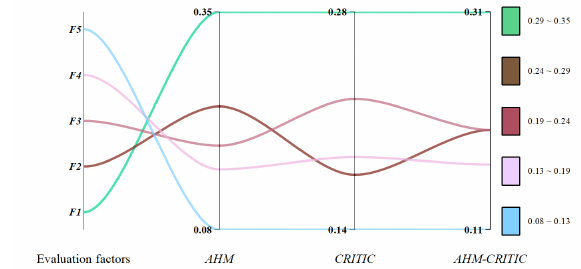
Fig. 5. Weighting Results and Coupling Weights of Different Methods.